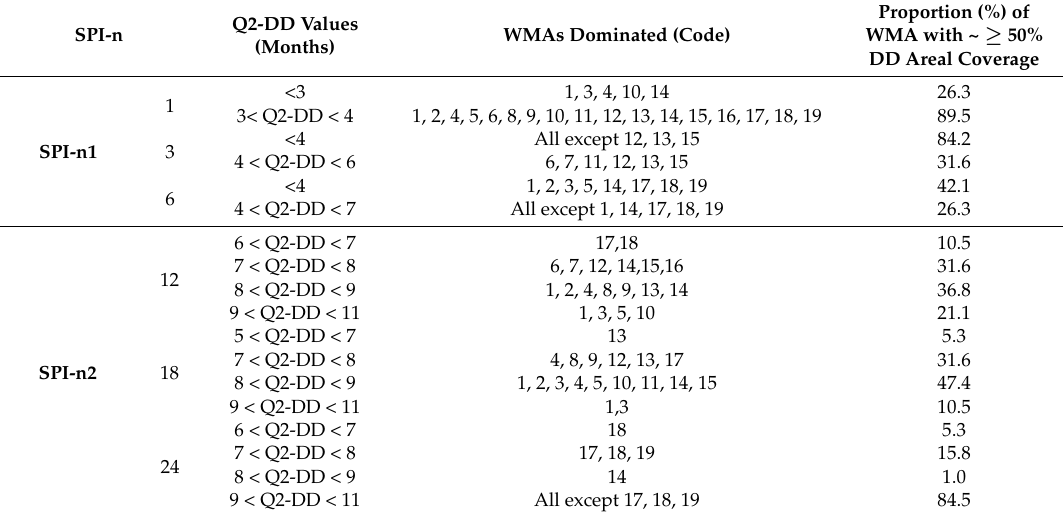
Figure 4. Spatial-temporal distribution of the 50th percentile of drought duration derived from SPI-1, SPI-3, SPI-6, SPI-12, SPI-18, and SPI-24 accumulation periods. Table 4. Distribution of Q2-DD domains across WMAs.